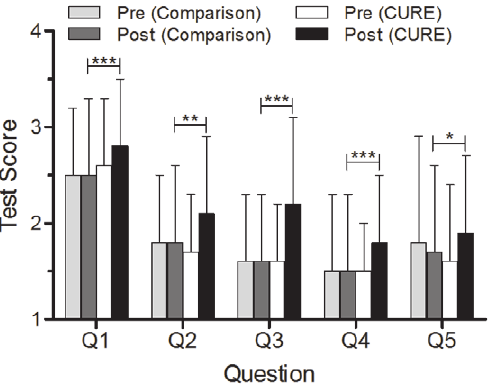
Figure 1. Cohort 1 (CURE) and Cohort 2 (Comparison) Pre- and Post-Test Scores (N=431). Mean scores for individual items of the pre-test for each cohort revealed no differences between groups for any of the items (Cohort 1, CURE, N=323; Cohort 2, Comparison, N=108). Post-test gains of Cohort 1 (CURE) relative to Cohort 2 (Comparison) were statistically significant for all questions. (Question Figure 2. Student Perceptions about Participation in the CURE